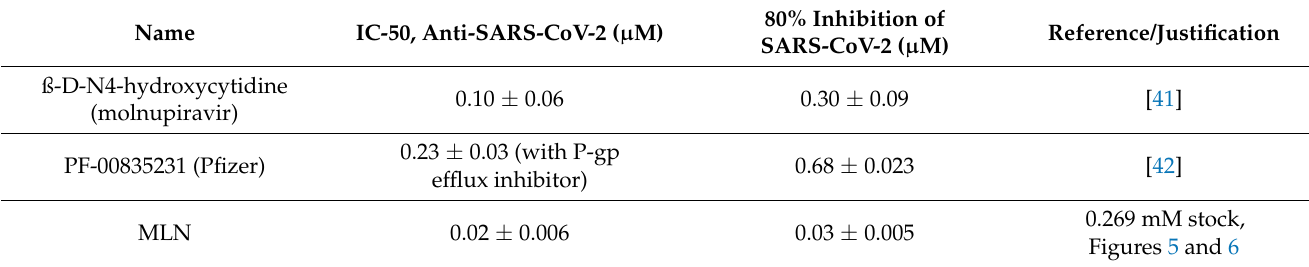
Figure 4. It shows a complete spike protein and MLN A/B binding pose to Heptad repeat 1 region of the S2 domain. Heptad repeats 2 region is absent in all crystalized structures as its presence destabilizes the structure. Table 1. Comparative potency breakpoints of leading antiSARS-CoV-2 agents in comparison with